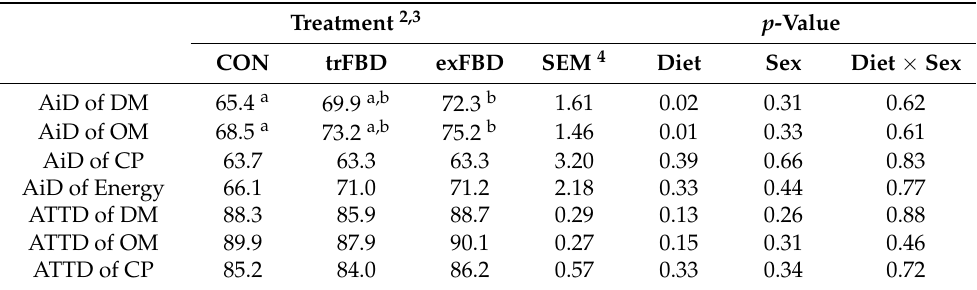
Table 4. Effect of partially replacing dietary soybean meal with field beans treated with propionic acid (trFBD) and extruded (exFBD) on apparent ileal digestibility (AiD) and apparent total tract digestibility (ATTD) of grow-finisher pigs ( n = 6 pairs of pigs/treatment) 1 .